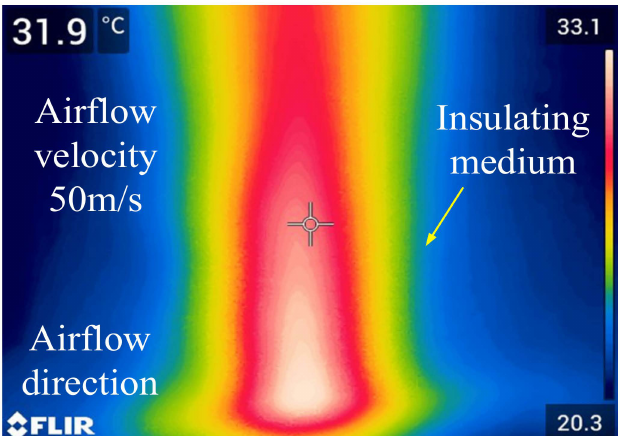
Figure 23. Insulation media surface temperature test graph at an airflow speed of 50 m/s.